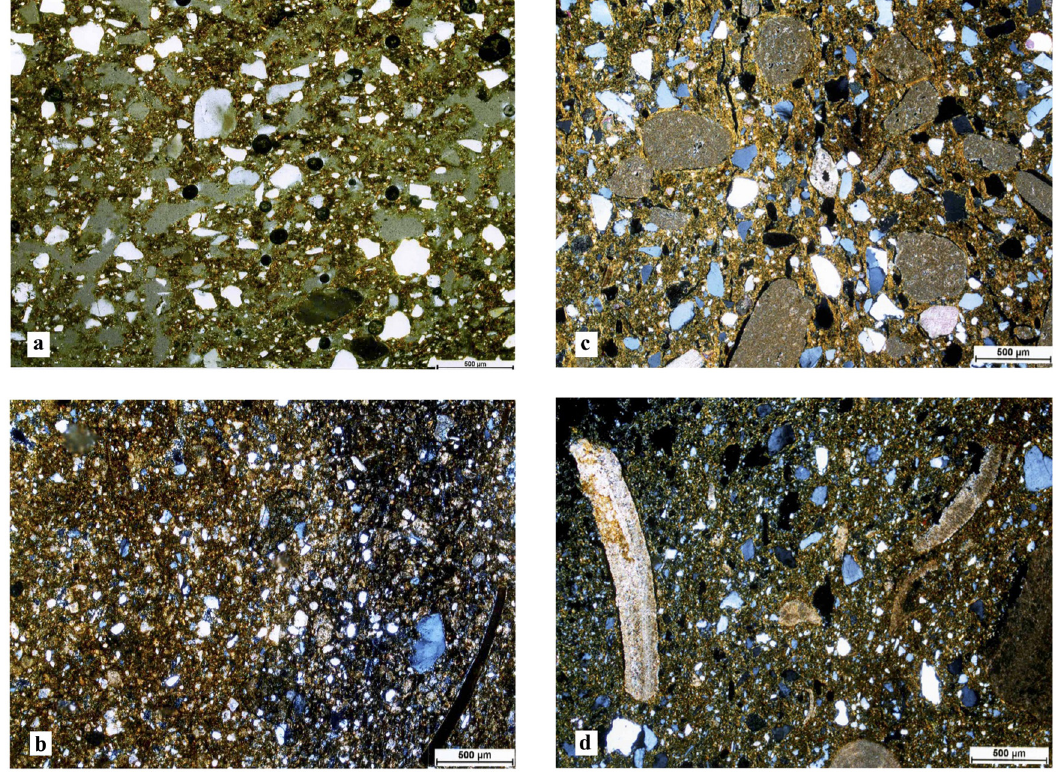
Figure 3: Two main types of clayey materials and the two main types of tempers identi fi ed at Cuiry - lès - Chaudardes. ( a )